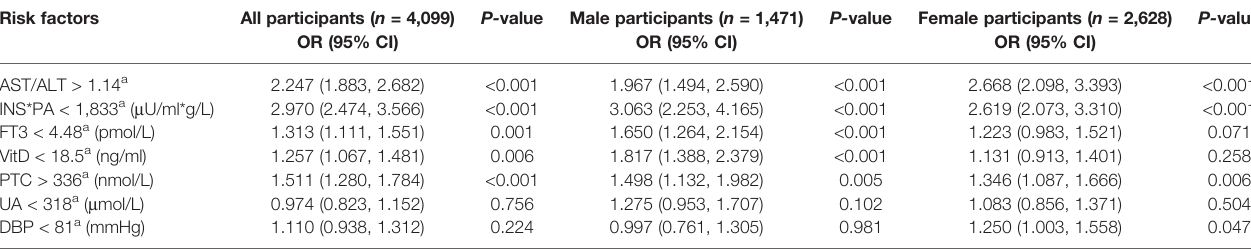
TABLE 3 | Risk factors for sarcopenia were determined by binary logistic regression